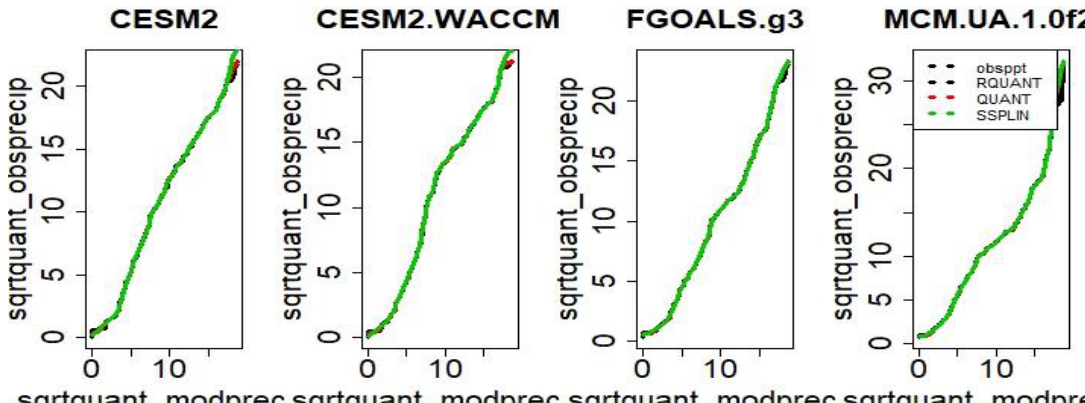
Figure A2. Square root quantile- quantile mapping of model precipitations (CESM2, CESM2-WACCM, FGOALS-g3, and MCM-UA-1.0f2) versus GPCC monthly observation precipitation.